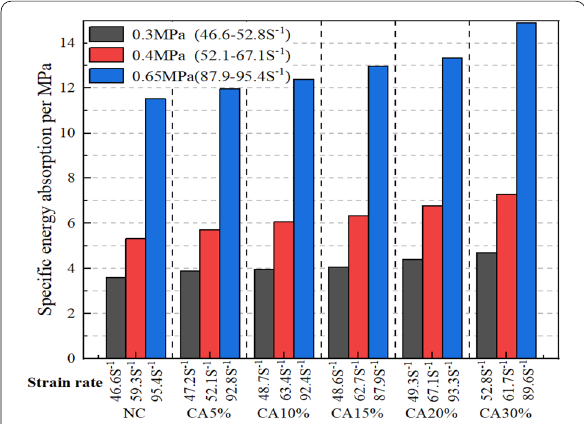
Fig. 17 Specific energy absorption per